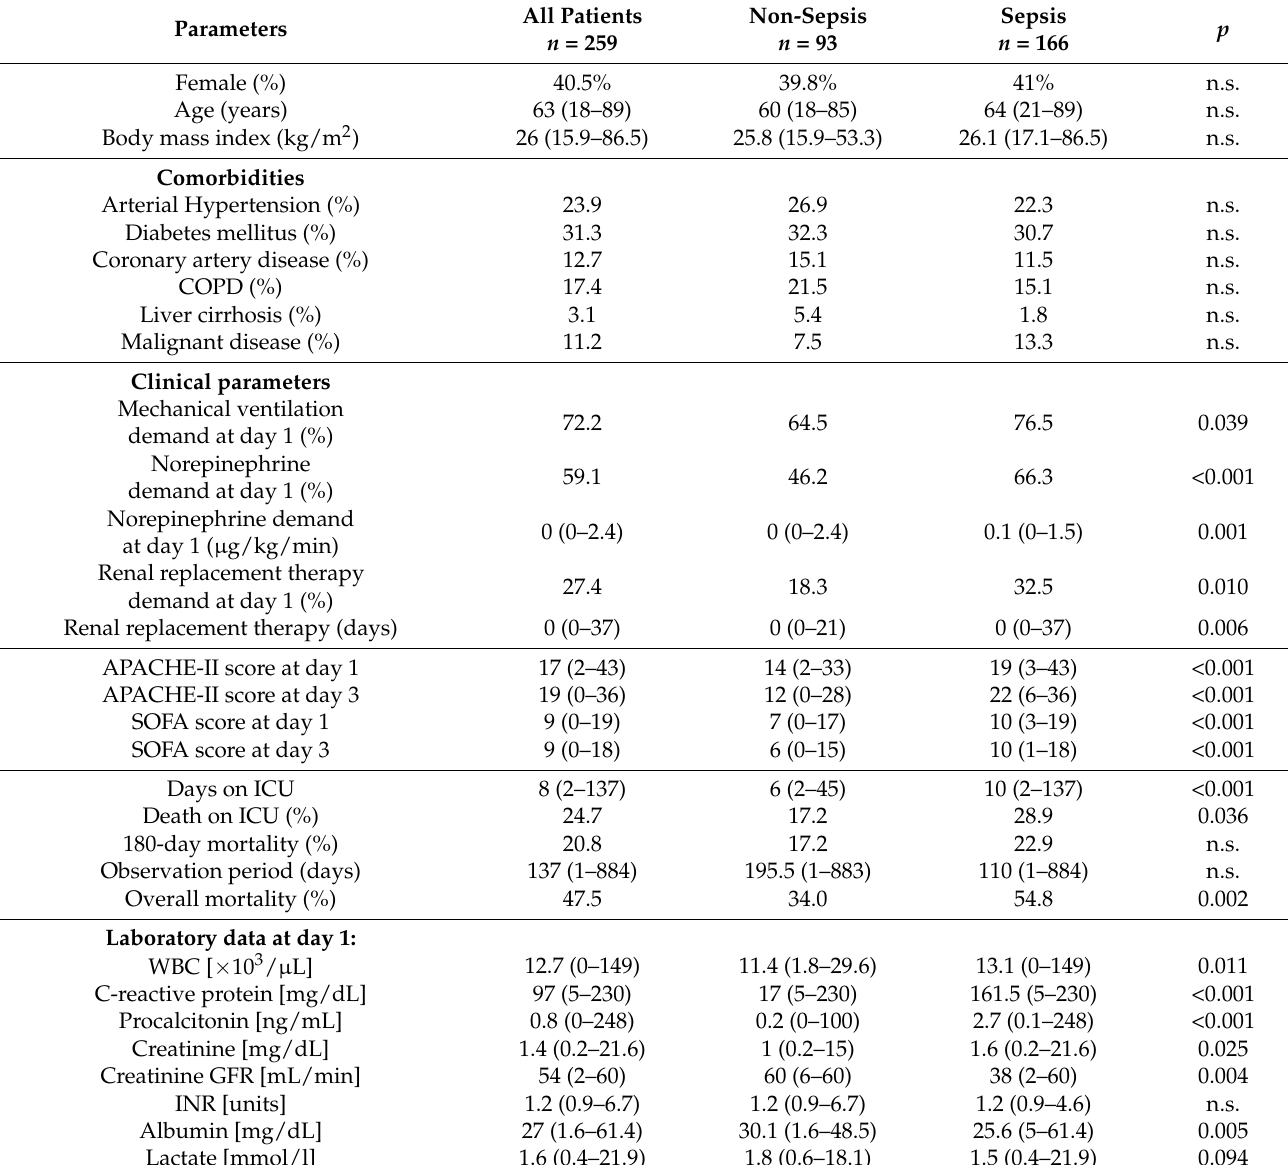
Table 2. Baseline patient characteristics at ICU admission divided by the presence of